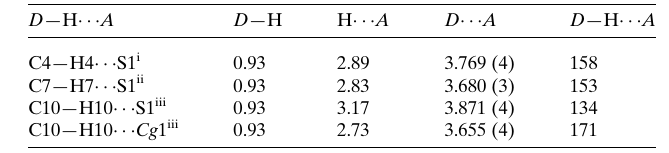
Table 2 Hydrogen-bond geometry (A˚ , (cid:3) ) for ( II ). Cg 1 is the mid-point of the C1 N1 group.